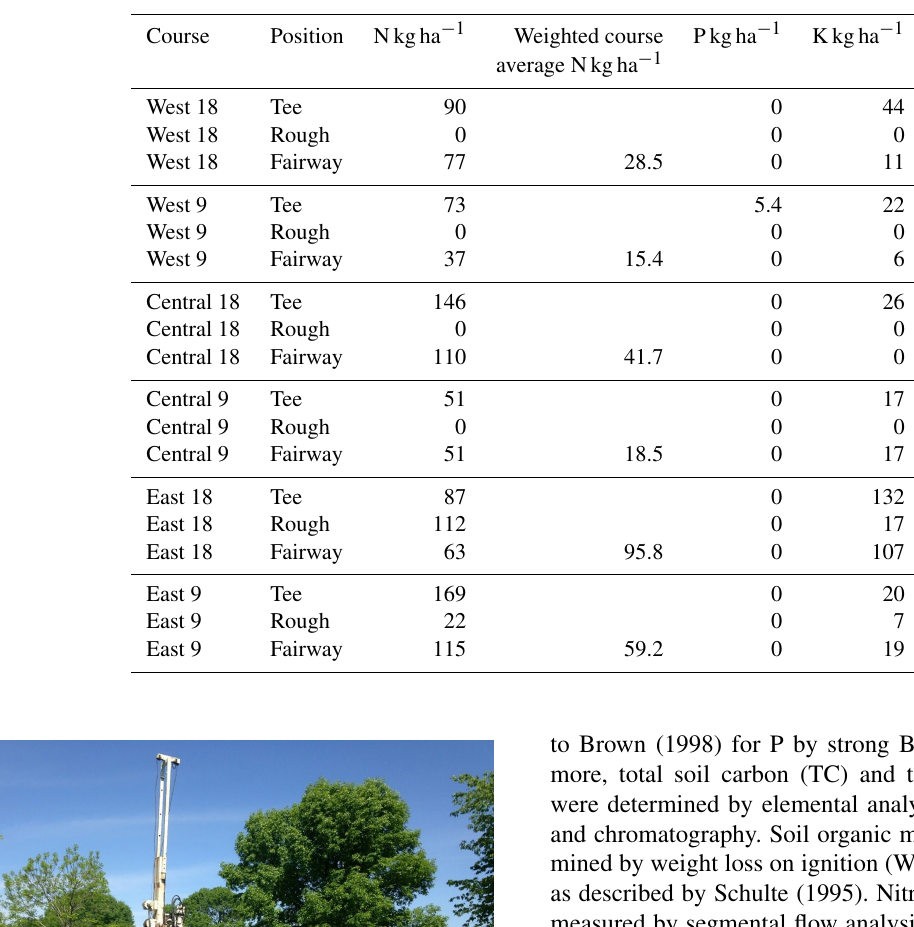
Table 2. Summary of annual fertilizer rates at selected Iowa golf courses.